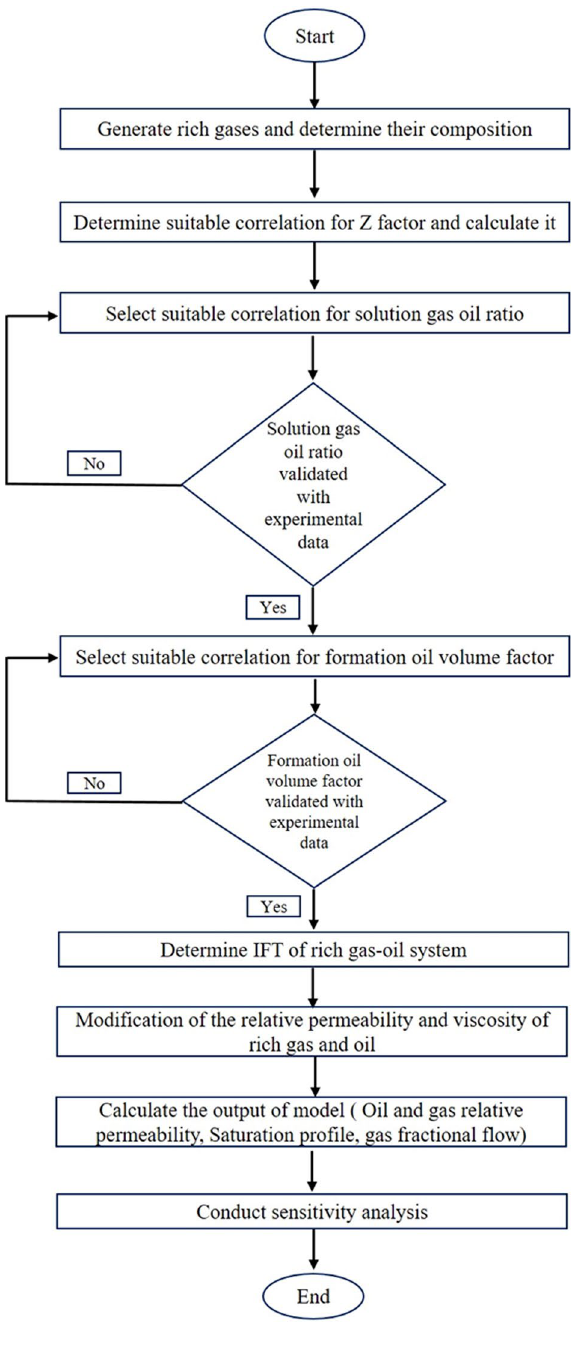
Figure 1. The Flow chart of the present